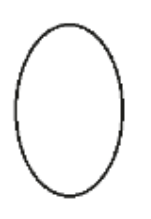
on contour feature. The contour based method mainly uses